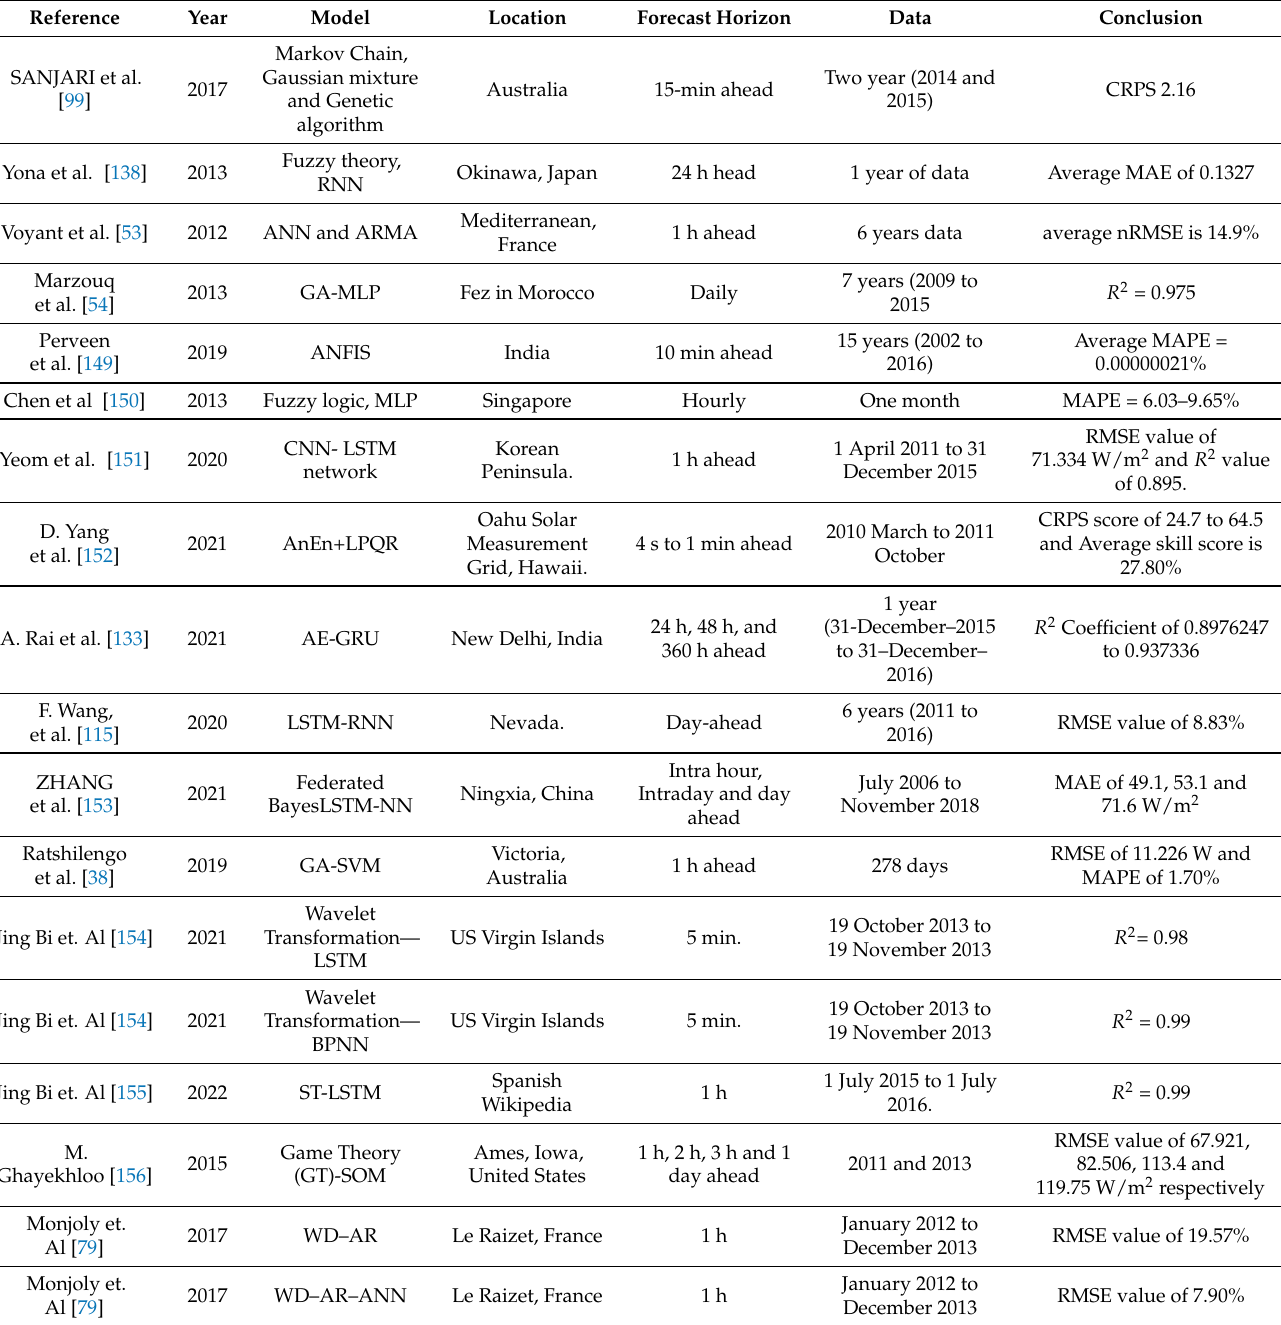
Table 10. Summary of hybrid